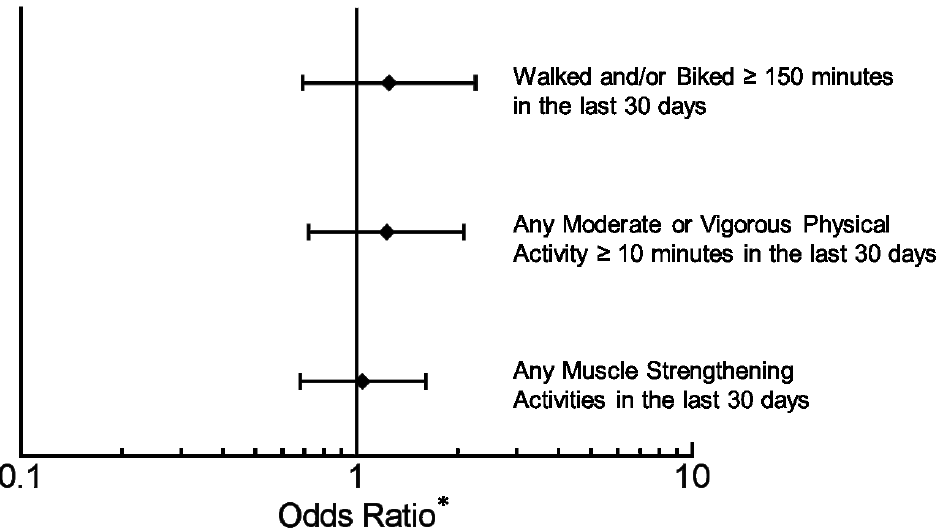
Figure 3. Adults taking antidepressants had similar self-reported measures of physical activity in the 2005–2006 National Health and Nutrition Examination Survey compared to those not taking antidepressants. Adjusted for Patient Health Questionnaire-9 depression score, tobacco/nicotine use, antipsychotic use, use of insulin, use of non-insulin diabetic medications, use of lipid-lowering medications, number of non-psychiatric/non-diabetic medications, self-assessed physical activity level, BMI category, education, race/ethnicity, and age. * Odds Ratio (OR) with 95% CI’s of antidepressant users compared to non-users.